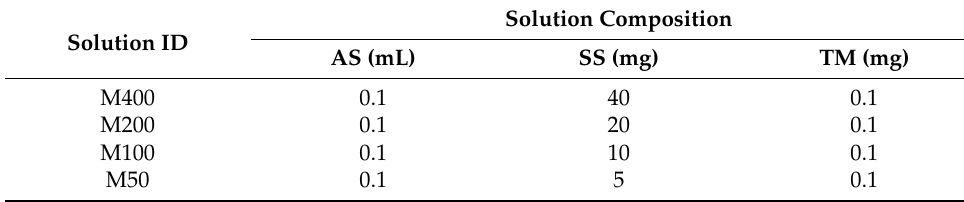
Table 1. Compositions of the tested ternary